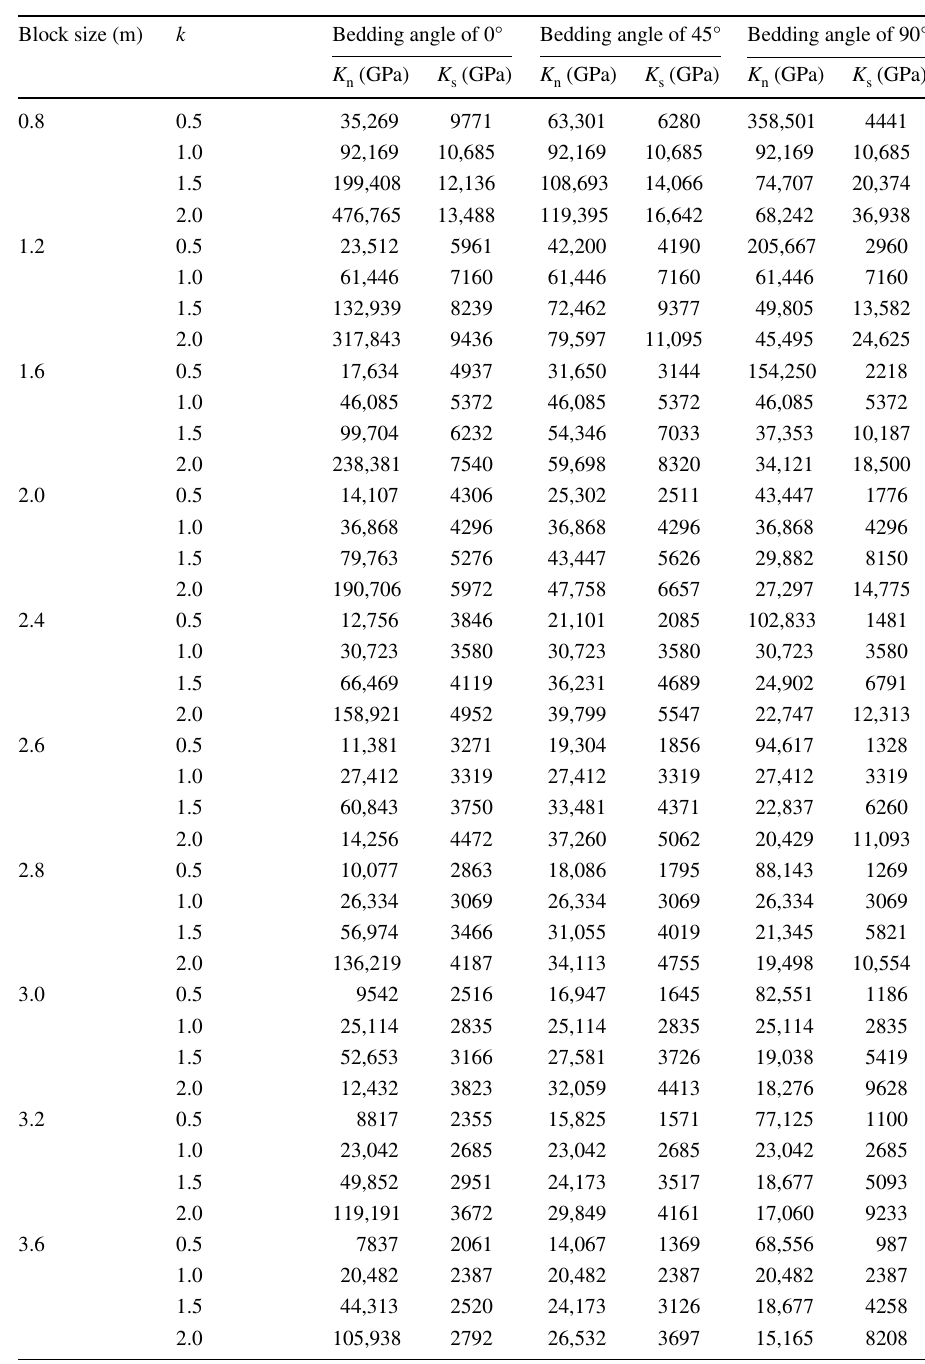
Fig. 11. The mechanical parameters of each block gradu-